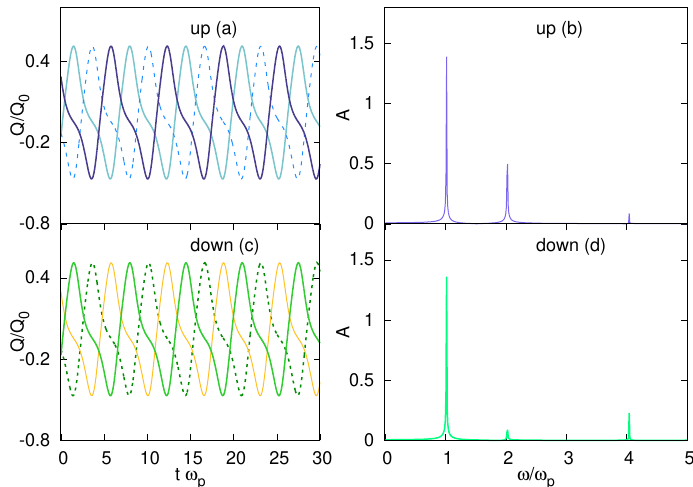
Figure 3. Charge traveling wave for the first, second and third superconducting layers are presented for current value of I / I c = 1.3 for the increase ( a ) and the decrease ( c ) of current. Corresponding results of Fast Fourier Transform (FFT) analysis are presented in ( b , d